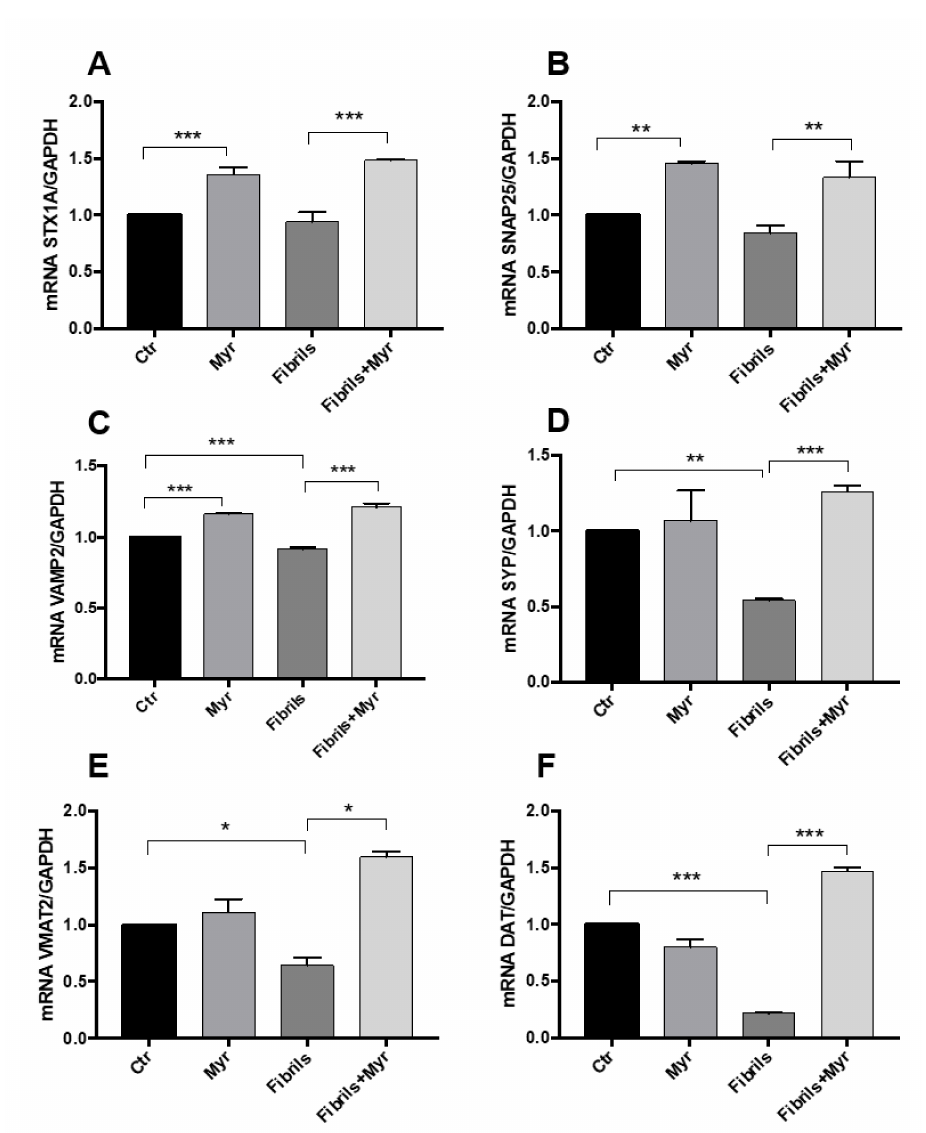
Figure 6. qRT-PCR quantification of genes involved in SNARE complex formation. ( A – D ) neuro- transmitter vesicle transport, VMAT2 ( E ) and dopamine transporter DAT ( F ). GAPDH was used as a housekeeping gene. All data, derived from three independent experiments, are expressed as mean ± SEM (* p < 0.05; ** p < 0.01; *** p < 0.001); one-way ANOVA test followed by Bonferroni correction was used for all